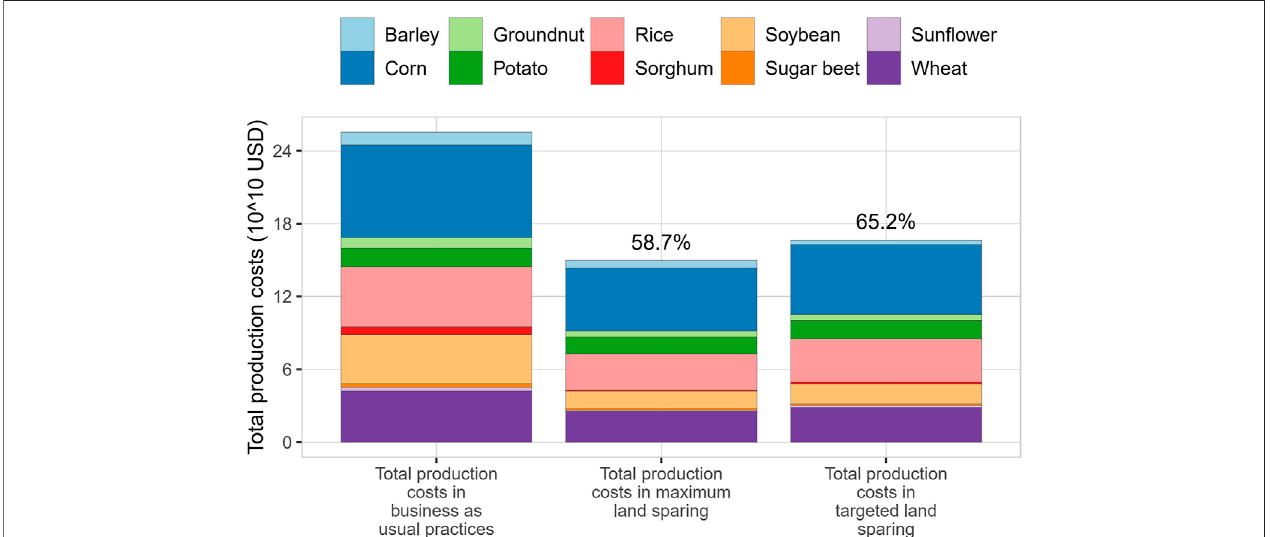
FIGURE2| Globalcostsofproductioninthebusinessasusual,andthetwolandsparingscenarios.Thestackedbarsdemonstratetheestimatedtotalcostsforthe production of 10 major crops in actual business as usual for the reference period of 2011 – 2015 (left bar), estimated total costs for the production in the maximum land sparing(MLS)scenario (middlebar)andsparing ofatleast 20%ofcroplandineach simulation unitand entirelyabandoningbiodiversity hotspots (TLS)(rightbar). Ontop of the middle and right bar, percentage values regard total costs of production for the 10 considered crops relative to the total costs in the business as usual scenario. In a global scale, total costs of production in BAU are approximately $255.39 bn while in the sparing scenarios costs are approximately $149.74 and $166.49 bn in MLS and TLS, respectively.